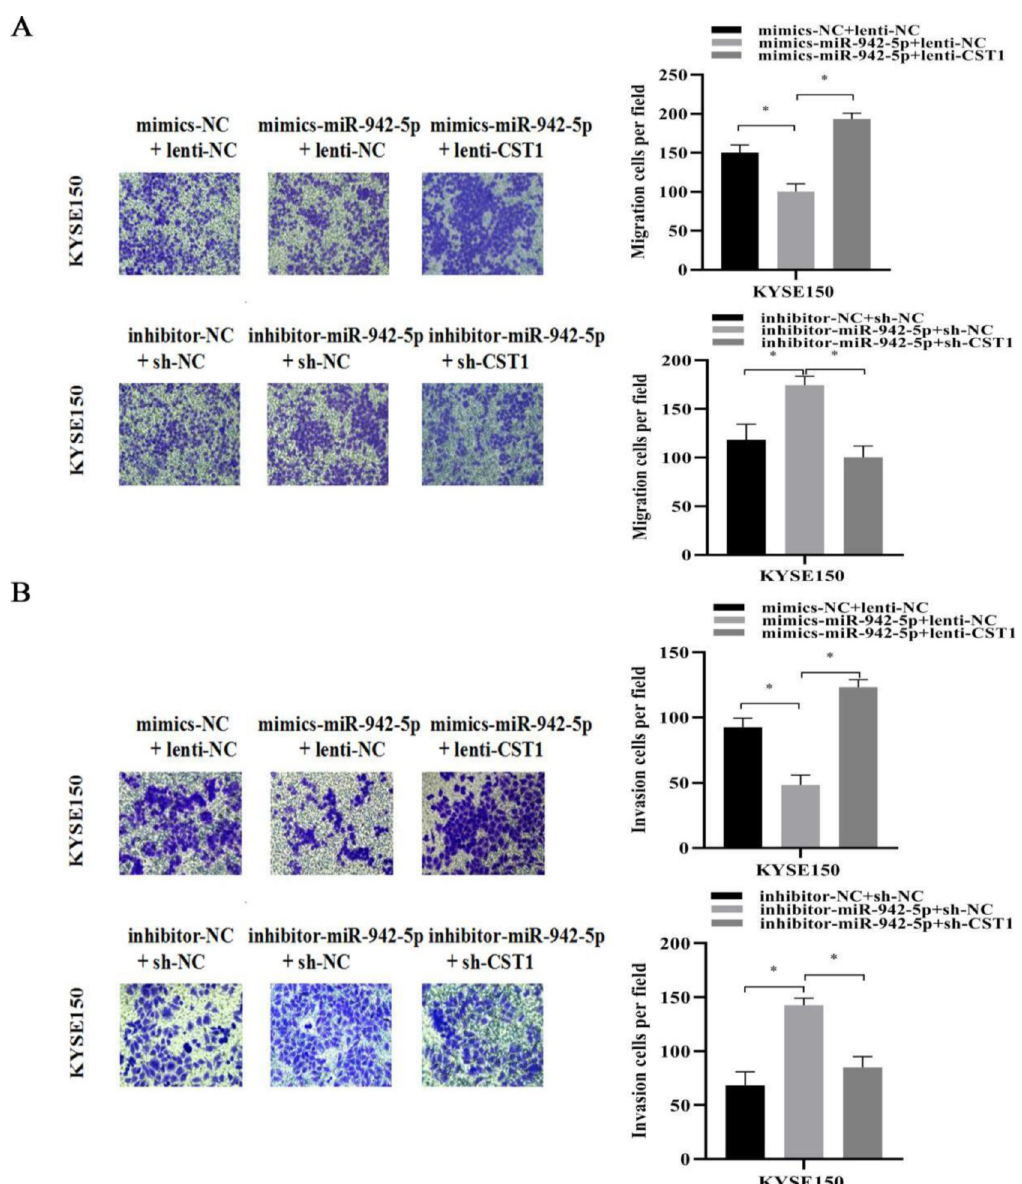
Fig 8. Effect of miR-942-5p on migration and invasion of ESCC cells ( × 200). (A) MiR-942-5p inhibits migration in KYSE150 cells. (B) MiR-942-5p inhibits invasion in KYSE150 cells. ( � P < 0.05).